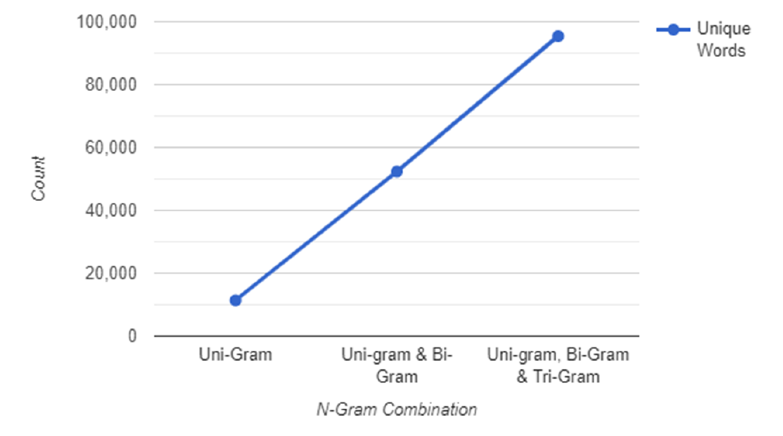
Fig. 3. The comparison of the number of features produced by the n-gram